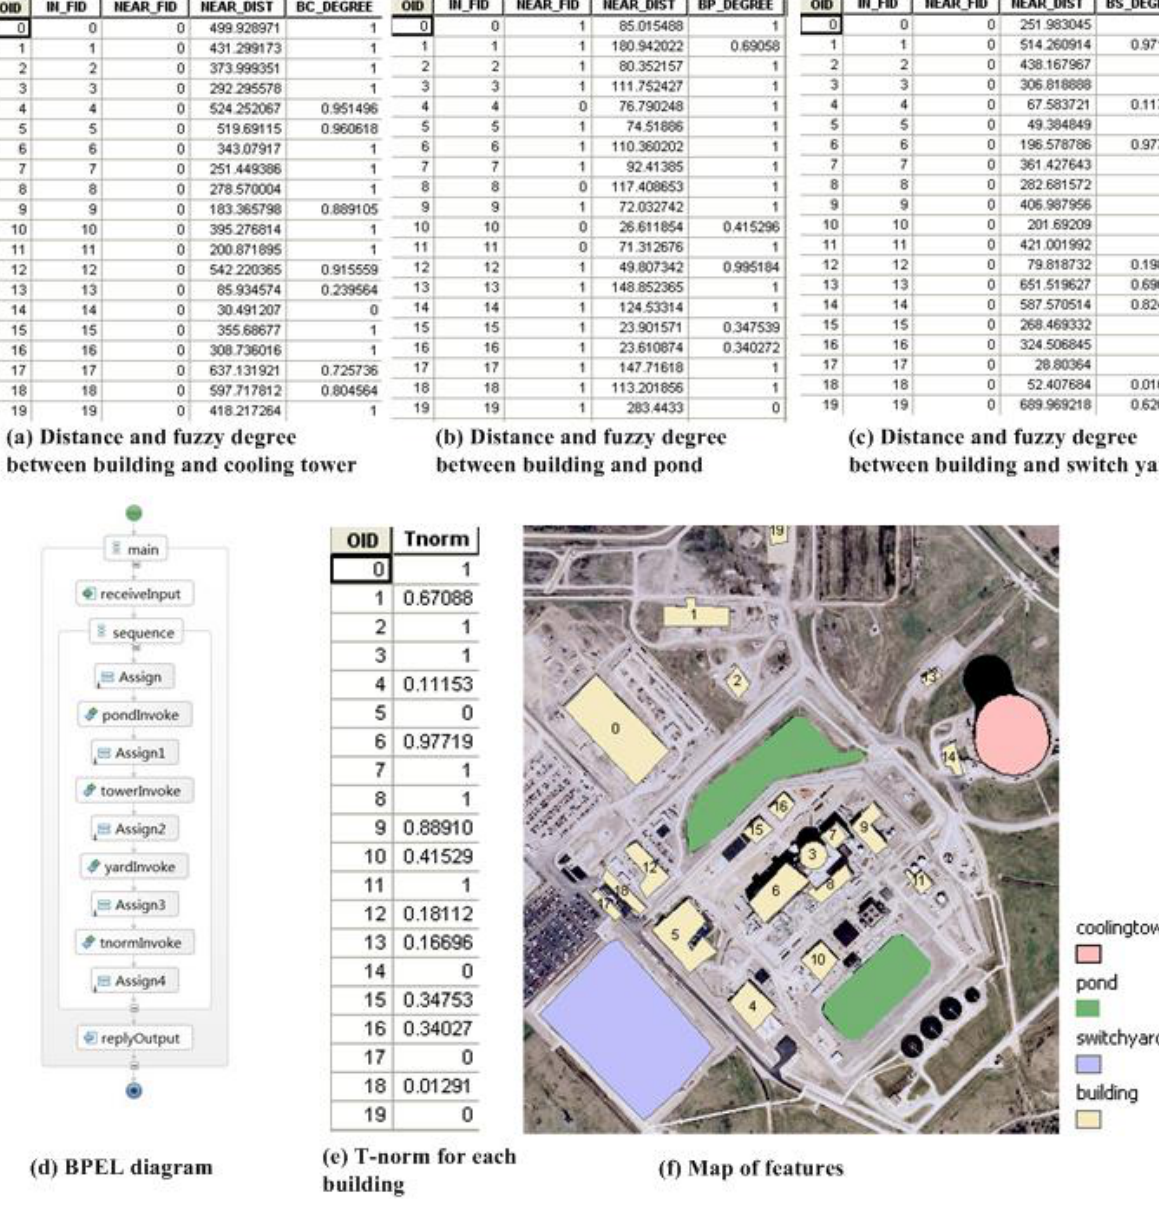
Figure 5. The workflow for the NPP